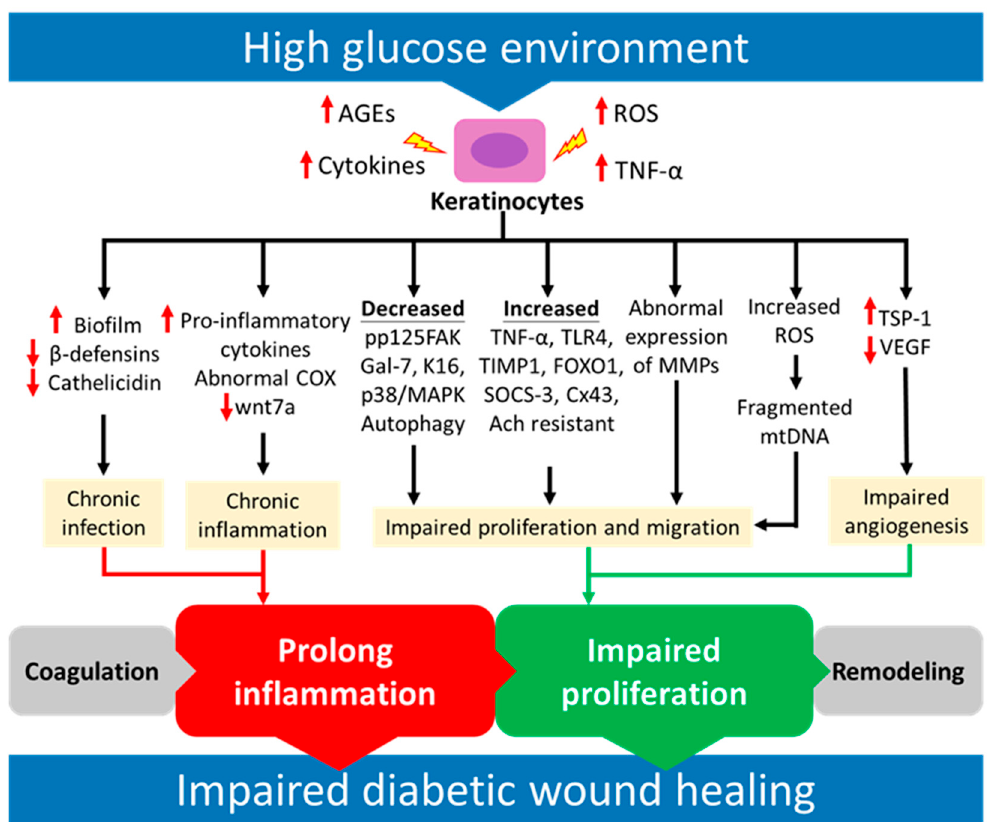
Figure 1. Scheme revealing different factors associated with dysfunctional keratinocytes in diabetic wound healing. Advanced glycation end products (AGEs), reactive oxygen species (ROS), and inflammatory cytokines may contribute to the impairment of keratinocyte migration and proliferation, chronic inflammation, chronic infection, and impaired angiogenesis in high glucose environments, leading to impaired diabetic wound healing due to prolonged inflammation and the impaired proliferation phase of wound healing.